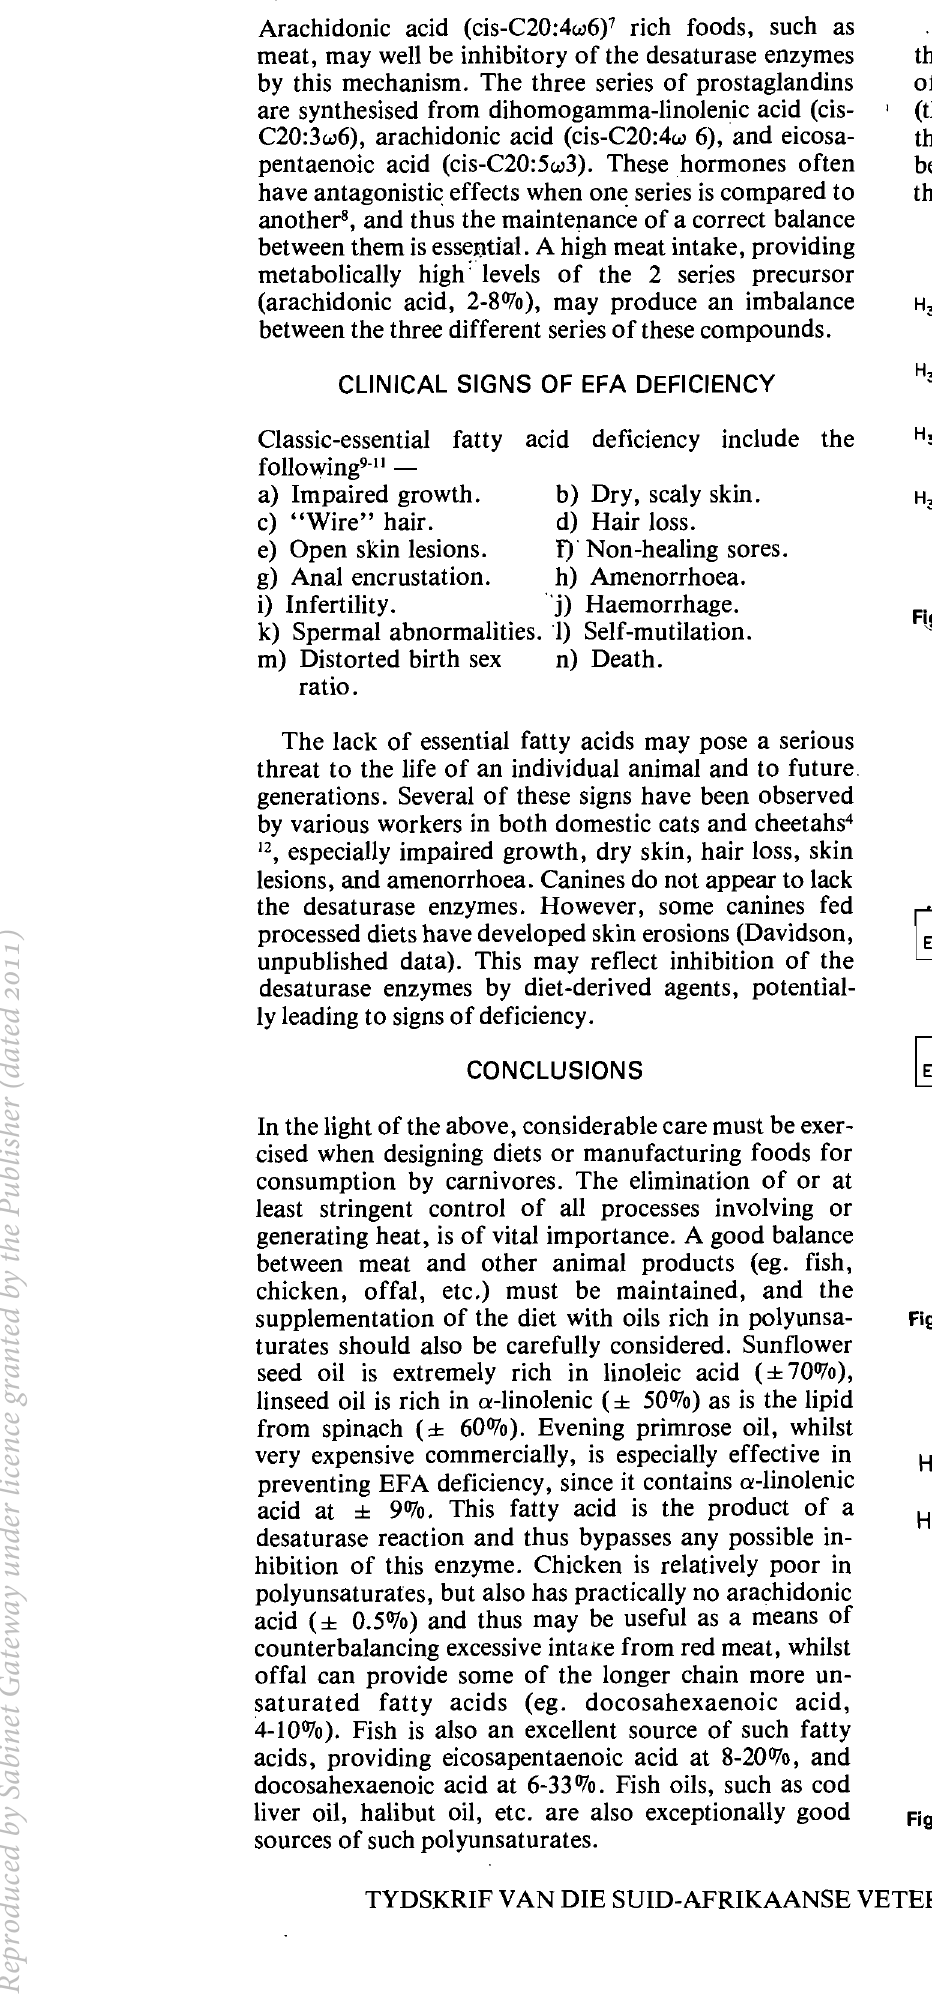
Fig. 2: The desaturation pathway of unsaturated fatty acids in animals.